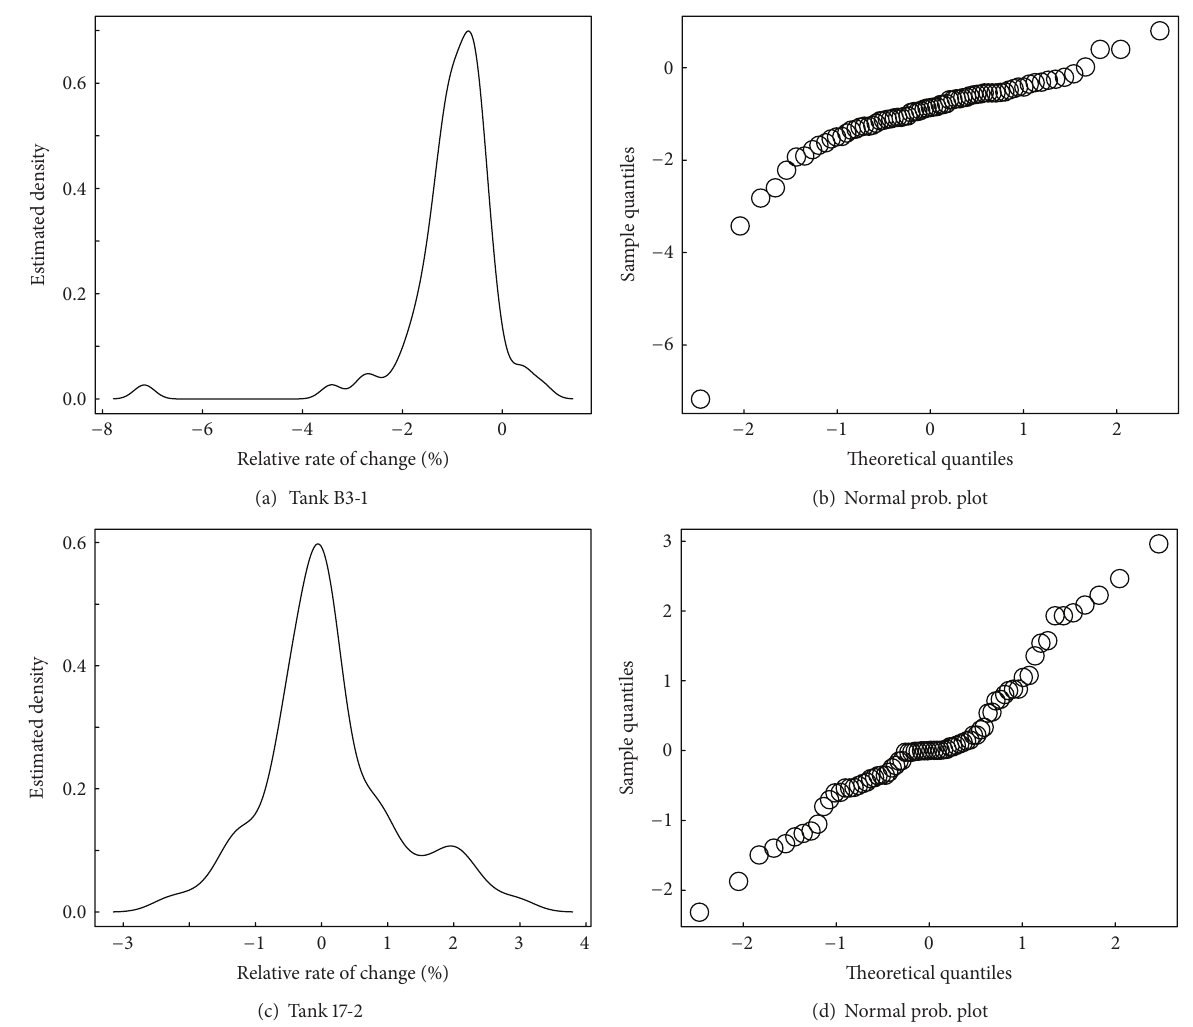
Figure 12: Qualitative evidence of mixtures during (a) 73 (from tank B3-1) and (c) 74 (from tank 17-2) tank wait modes.